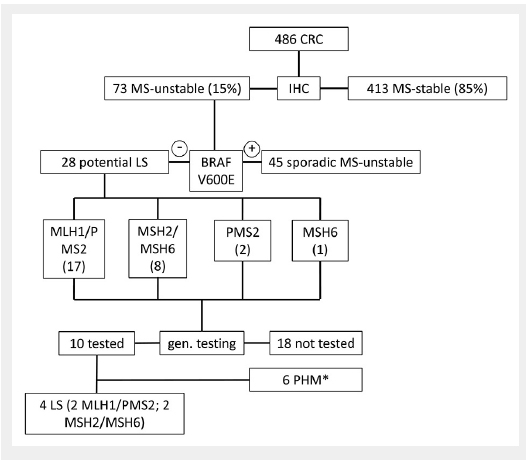
Study schema for universal screening for LS of all newly diagnosed CRC patients. Of all patients (n = 486), loss of MMR protein expression was found in 73 (15.0%) tumours. 28 (6.0%) were classified as potential LS carriers. Of the genetically tested potential LS carriers (10 out of 28 patients), 40% were first diagnosed with LS. * Promoter hypermethylation CRC = colorectal cancer; IHC = immunohistochemistry; LS = Lynch syndrome; MMR = DNA mismatch repair; MS =